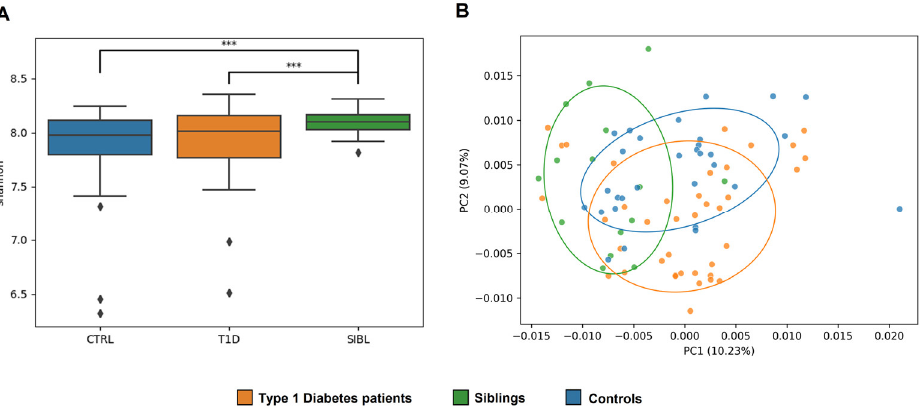
Figure 1. Analysis of GM ecology comparing the T1D, SIBL, and CTRL groups. Panel ( A ): Alpha diversity was calculated with QIIME using the Shannon diversity index and determining the p - value for group comparison by variance analysis (ANOVA). Significance (marked with *** when p - value < 0.01) was found for the comparisons between the T1D and SIBL groups ( p -value = 0.009) and between CTRL and SIBL ( p -value = 0.002). Panel ( B ): Principal coordinate analysis (PCoA) plots were constructed to illustrate the beta diversity of the samples, based on the Bray–Curtis distance matrix. To test the association between the covariates and beta diversity measures, a variance analysis method based on permutation was used (PERMANOVA, 9999 permutations, p -value =